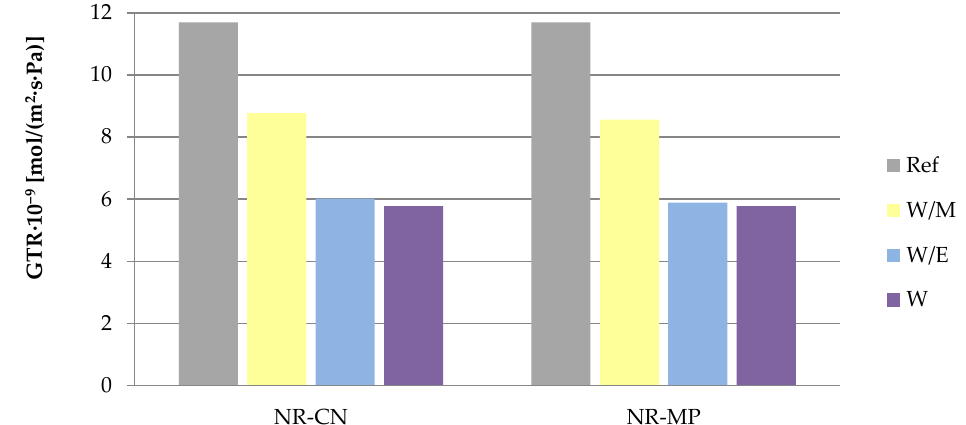
Figure 9. The gas transmission rate (GTR) values of tested vulcanizates.